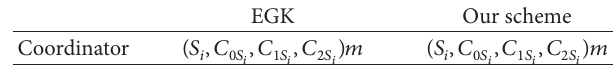
Table 3: Communication loads for rekeying. EGK Our